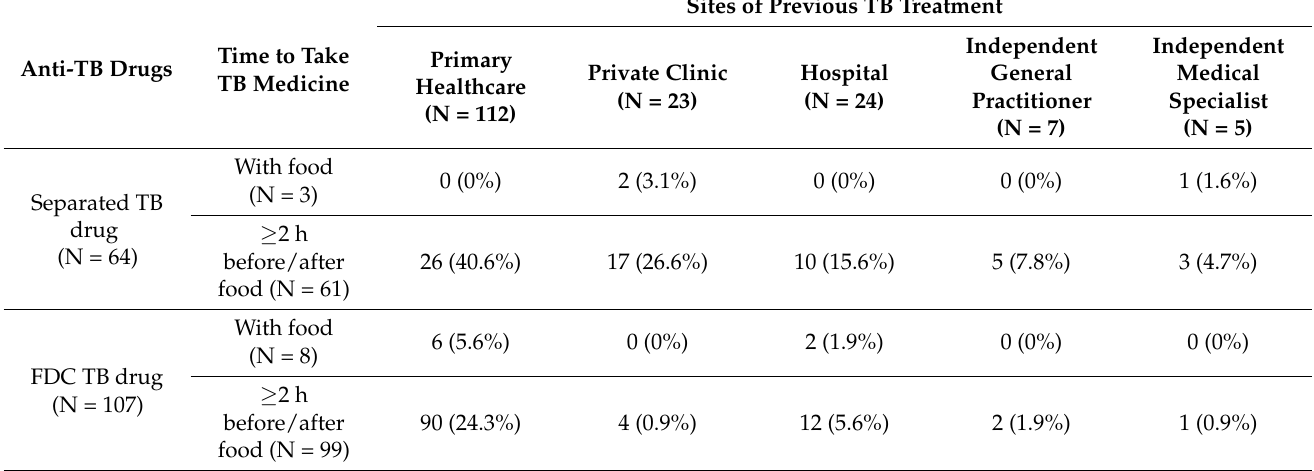
Table 3. Characteristic of Anti-TB drugs, Time to Take TB Drug, and Sites to Get TB Medication in the Previous TB Treatment (N =